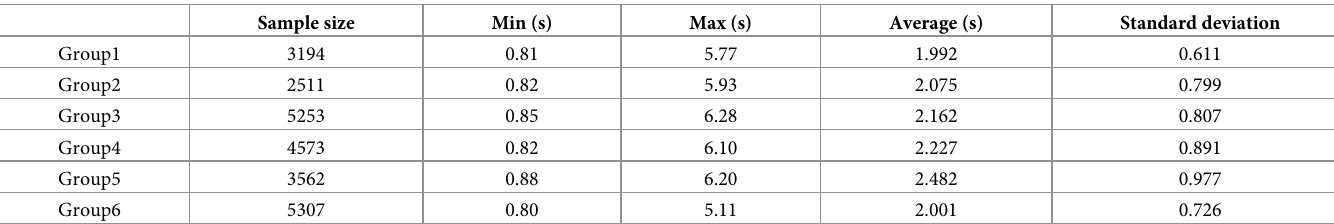
Table 1. Headway statistical description in each group.